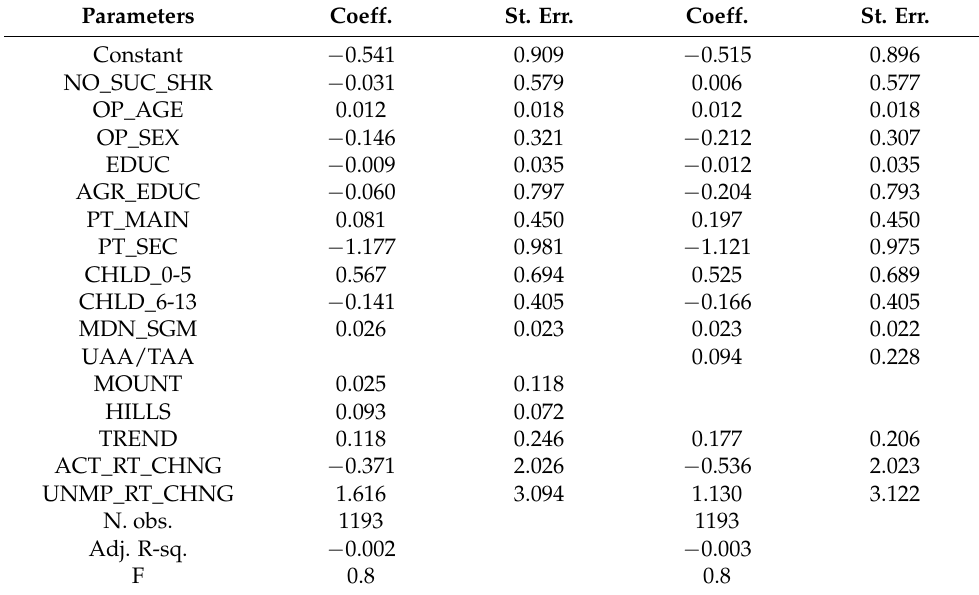
Table 4. Parameter estimates of the UAA decrease rate model. Parameters